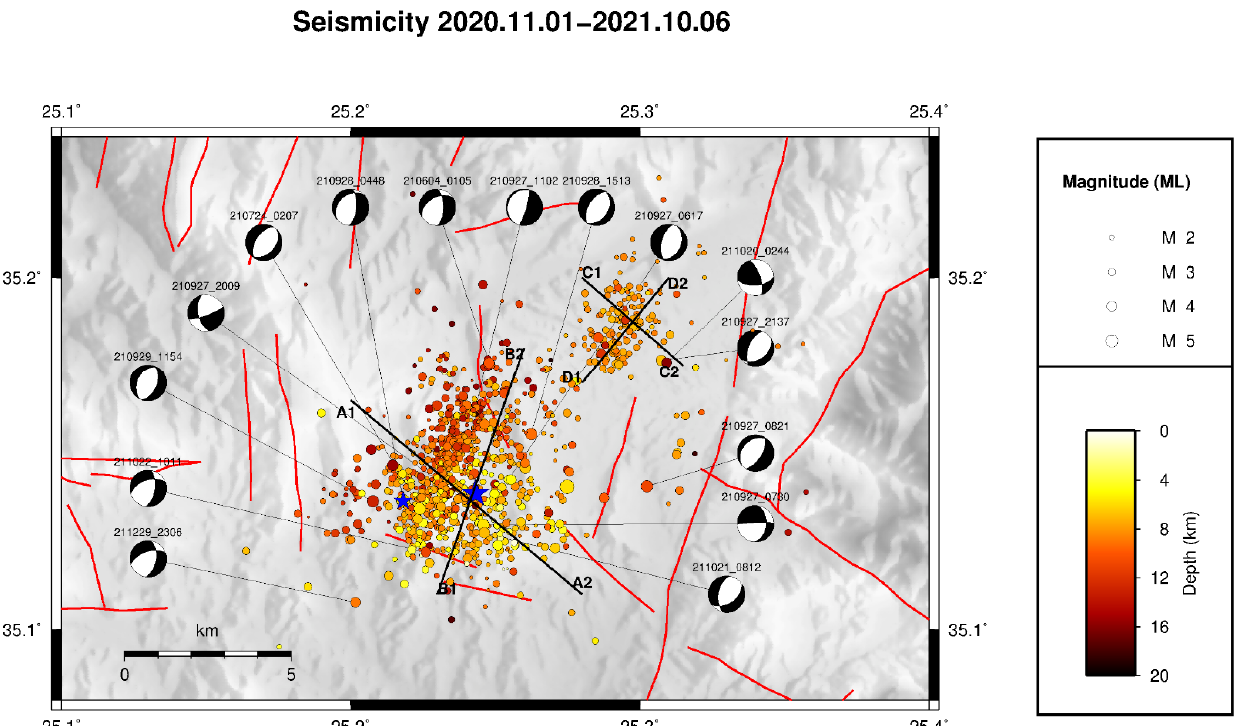
Figure 3. Shaded relief map showing the relocated seismicity, during the period 1 November 2020–6 October 2021, distributed in two main clusters. The events are coloured with respect to depth. The beach balls represent the lower-hemisphere projections of moment tensor solutions of the events with Mw >4.0 (source: NOA; see Table S2 for solutions). The focal mechanisms show normal-slip kinematics.